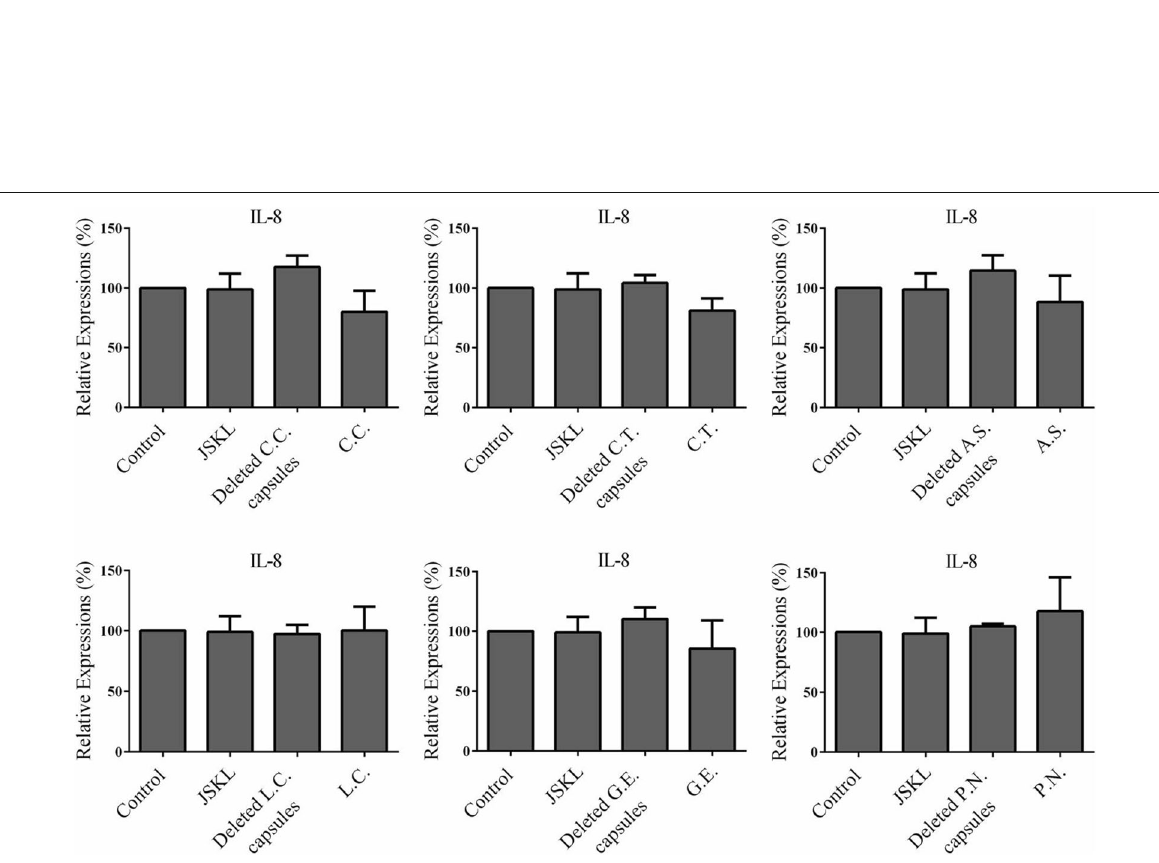
Fig. 4 Effect of JSKL, deleted-herb-capsule and single-herb-capsule on the expression of IL-6 in LPS-stimulated MH7A cells. *p <0.05 vs control group